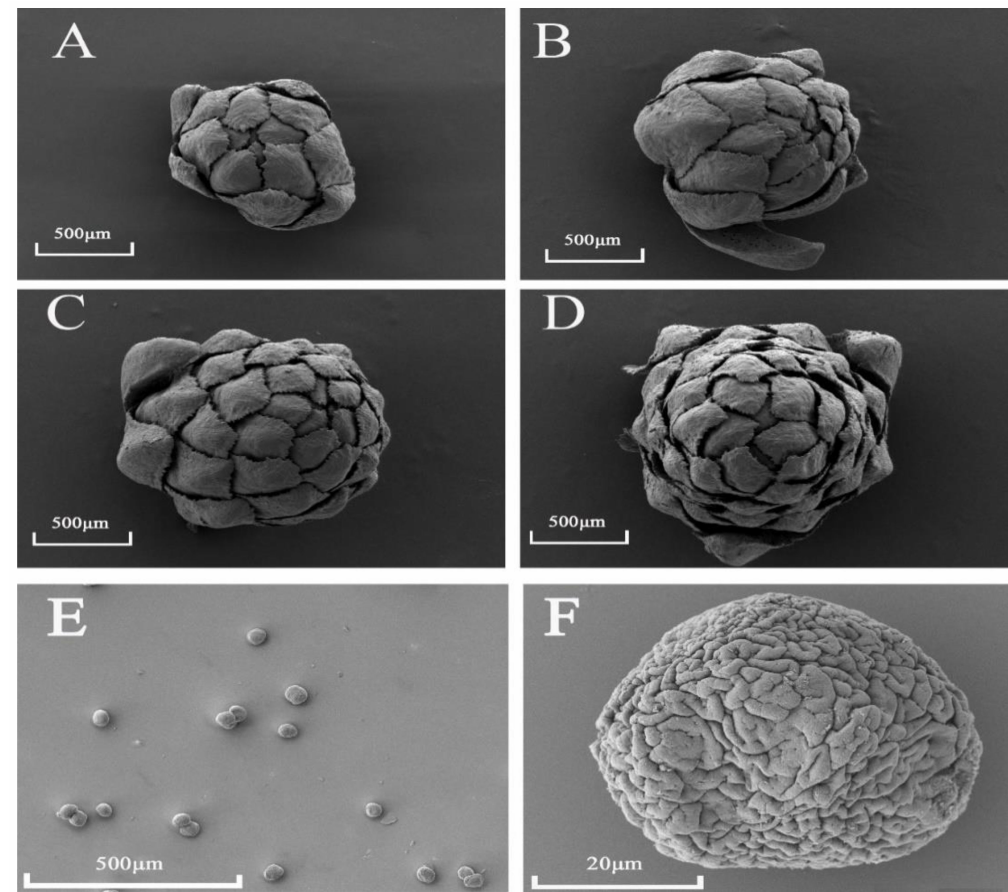
Figure 2. Scanning electron microscopic images of D. pectinatum male buds ( A – D ) and pollen grains ( E , F ). ( A ): April; ( B ): May; ( C ): July; ( D ): January; ( E , F ):